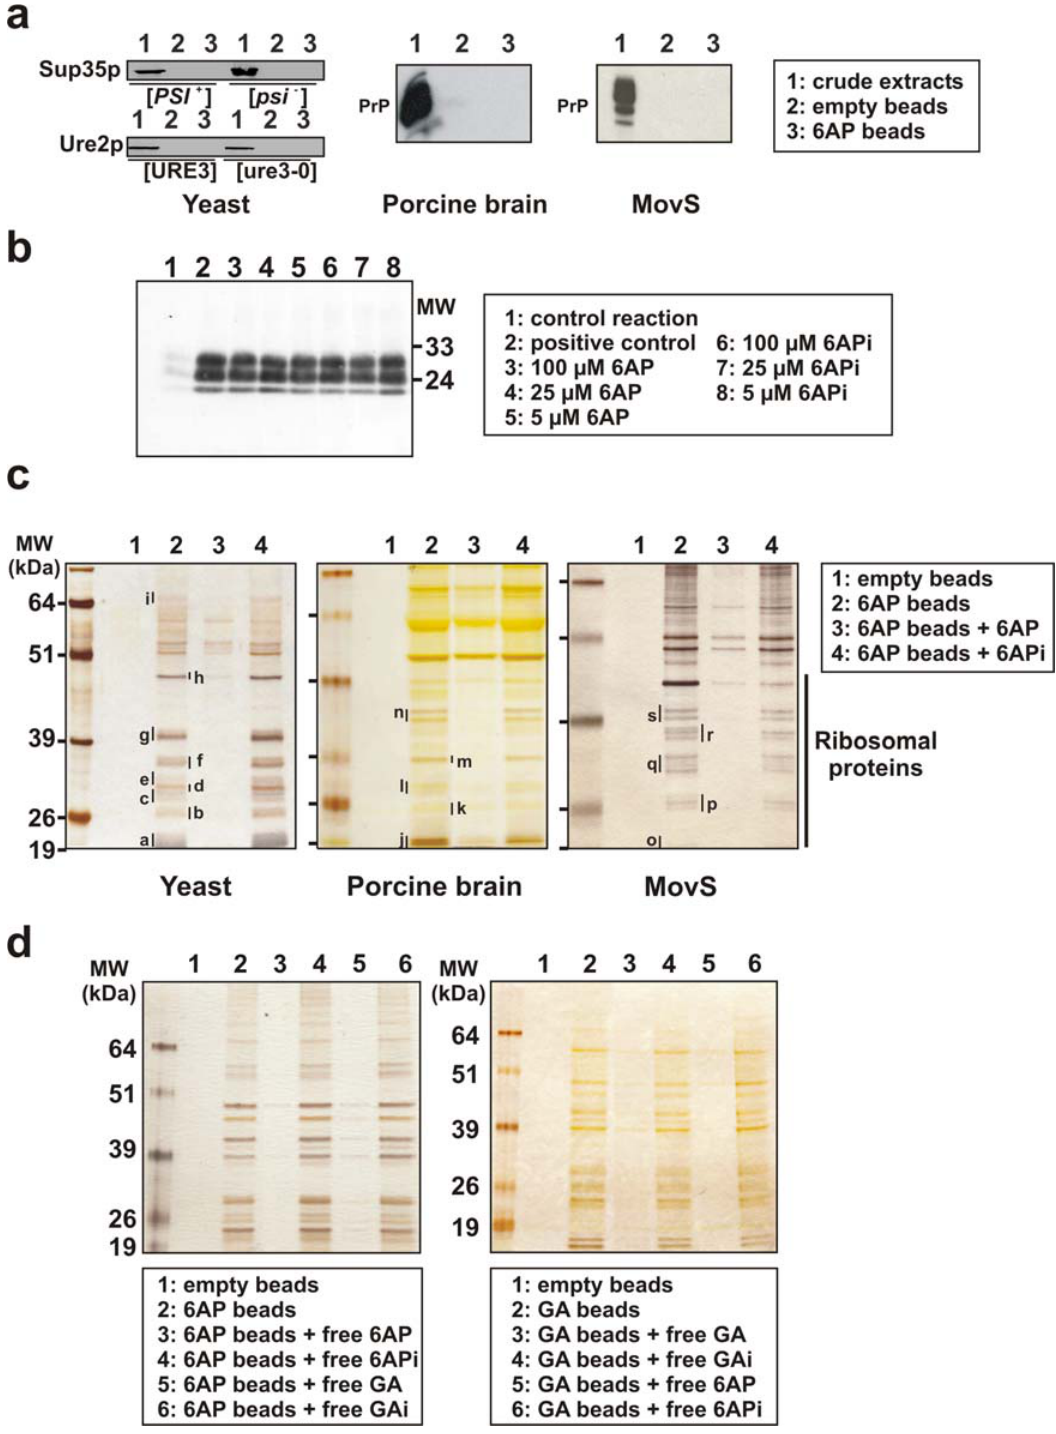
Figure 2. 6AP and GA do not interact with prion proteins but show specific interactions with ribosomal components and compete with each other for interaction with ribosomal components. a. Extracts from yeast (left panel), porcine brain (middle panel) and murine MovS6 cells (right panel) were incubated with 6AP beads. The beads were then washed extensively and the bound proteins analyzed by SDS-PAGE followed by Western blotting analysis using antibodies directed against Sup35p, Ure2p or PrP as indicated. 1: crude extracts, 2: control beads without 6AP, 3: chromatography using 6AP beads. Note that none of the three prion proteins binds to 6AP beads. b. Protein Misfolding Cyclic Amplification (PMCA) reactions performed in the presence of various compounds and then subjected to proteinase K digestion followed by Western blot analysis using an anti-PrP antibody. All samples contain a mixture of normal and scrapie brain homogenates in addition to the tested compounds at various concentrations as indicated in the right panel. Note that both 6AP and 6APi are unable to inhibit in vitro conversion of PrP C to PrP Sc . c. Extracts from yeast (left panel), porcine brain (middle panel) and murine MovS6 cells (right panel) were incubated with 6AP beads. The beads were then washed extensively and the bound proteins analyzed by SDS-PAGE. Lane 1: control beads without 6AP, lane 2: chromatography using 6AP beads, lane 3: